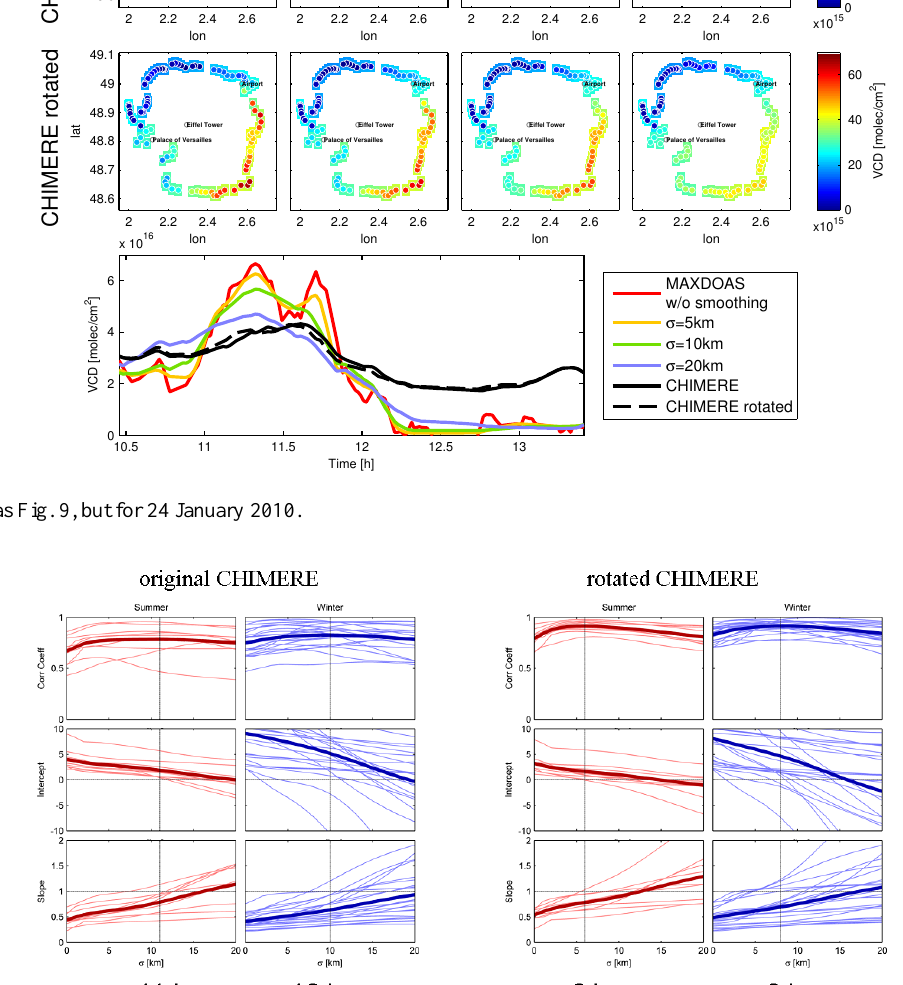
Figure 11. Results of the spatial correlation analyses between CHIMERE and car-MAX-DOAS data for individual days (thin lines) as function of the smoothing kernel (measurements along large circles). The thick lines indicate the averages of the individual days. Left: original CHIMERE data; right: rotated CHIMERE data. The vertical lines indicate the smoothing kernels, for which the highest correlation coefficients are